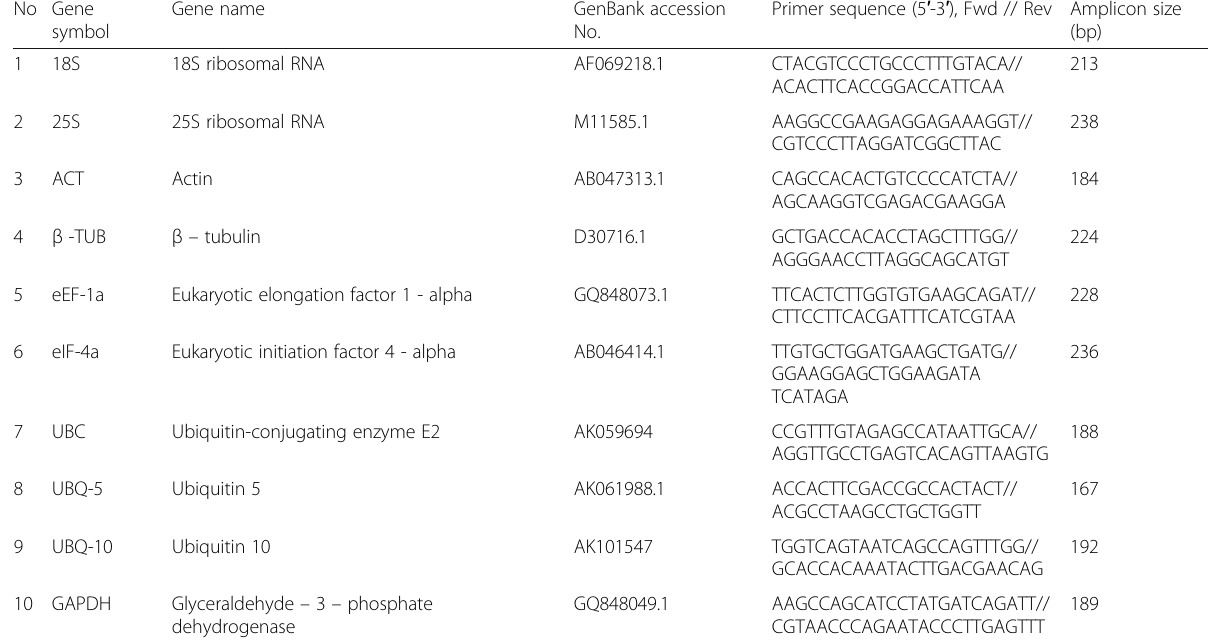
Table 1 List of the internal reference genes and the amplification specifications in qRT-PCR No Gene Gene name GenBank accession symbol